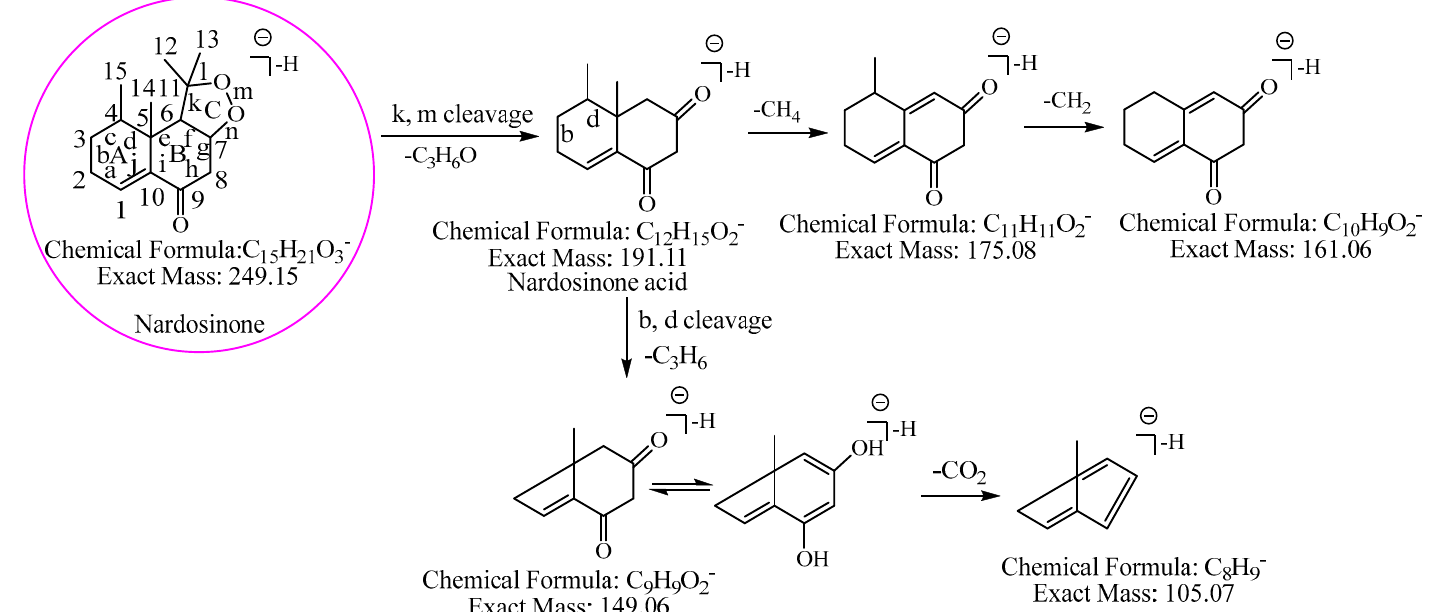
Figure 2. The proposed fragmentation pathway of nardosinone. The pink circle represents nardosinone, and the C-C bonds and carbon atoms in the skeleton were designated by the letters a–n and numbers 1–15; A, B and C represent the three rings, respectively.